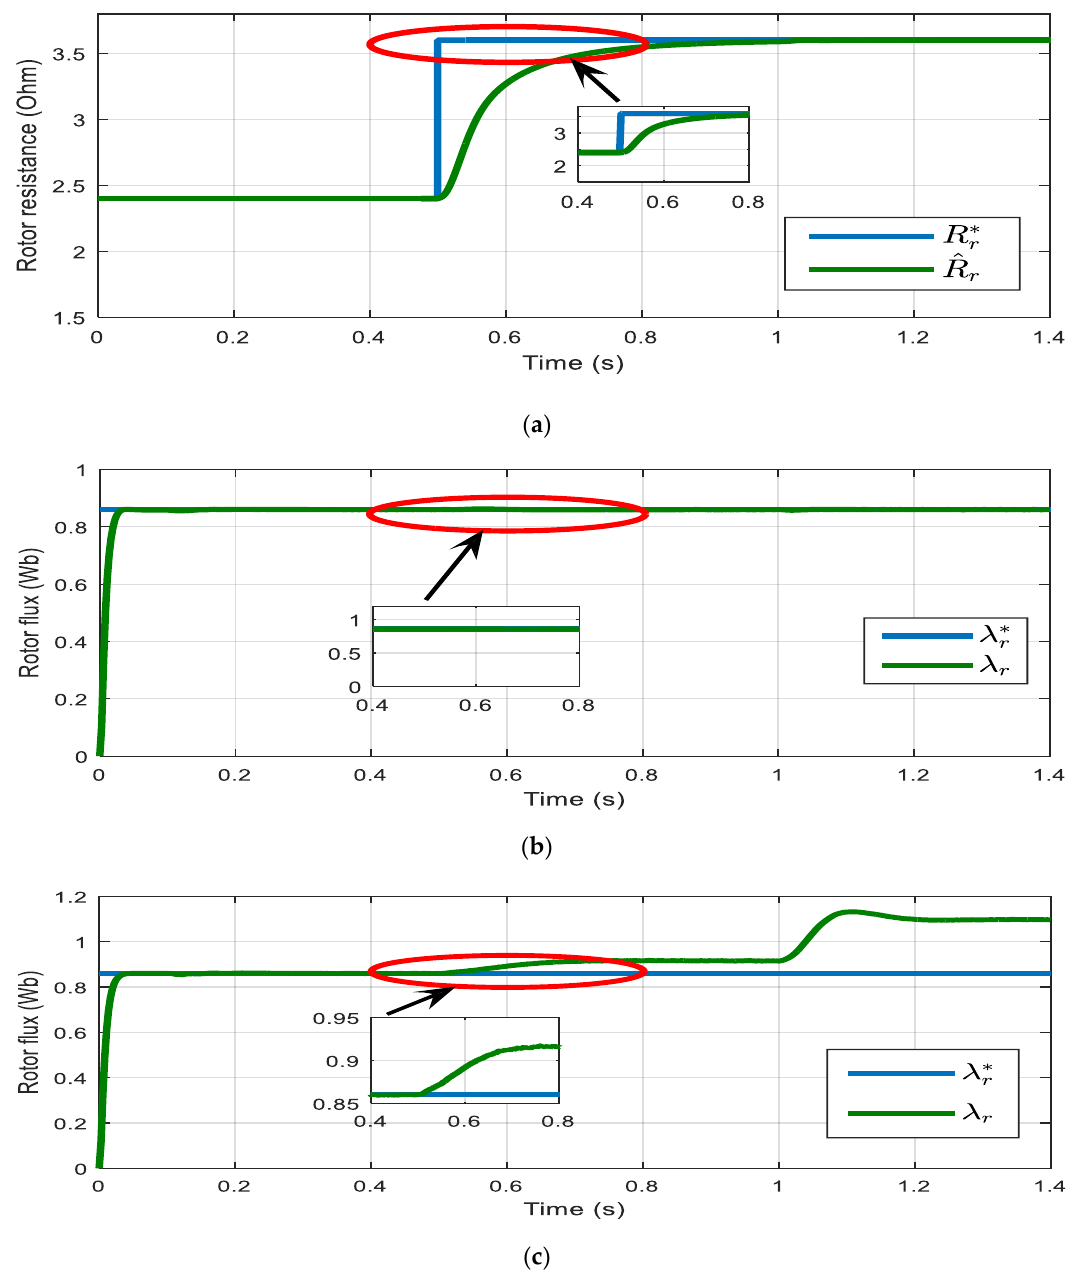
Figure 4. Dynamics of estimated rotor flux with ( b ) and without ( c ) sliding mode observer (SMO) under varying rotor resistance ( a ).